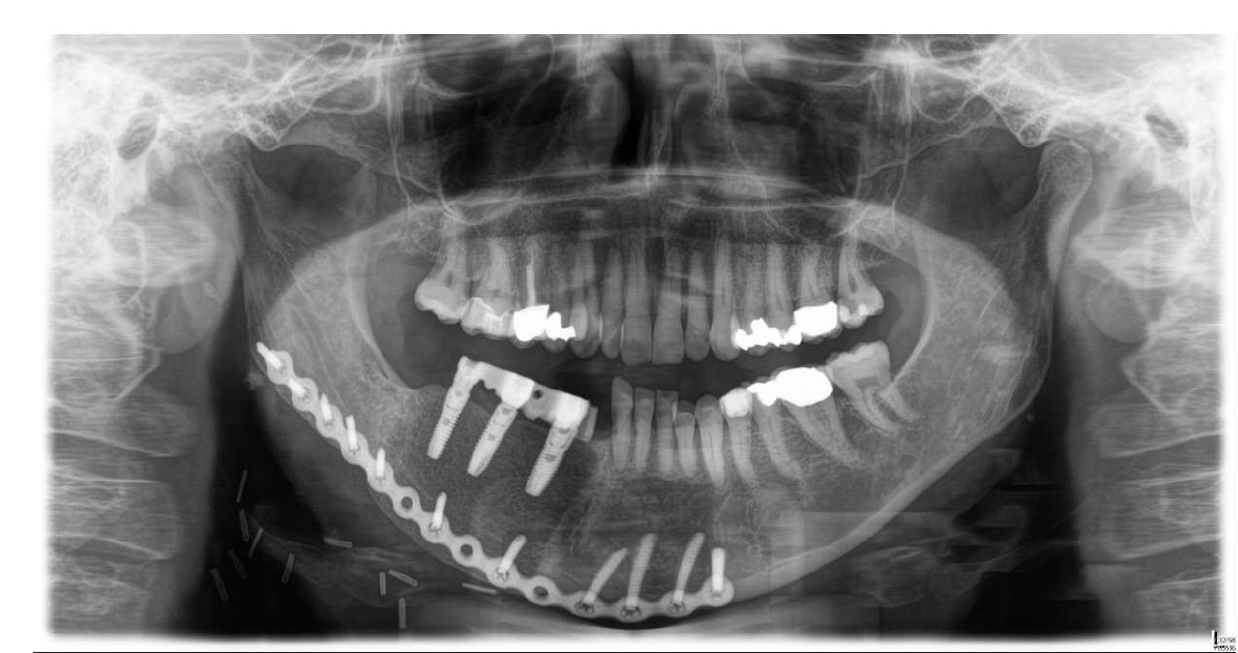
Figure 6. X-ray showing the postoperative situation, one year after surgery. Implant-prosthetic rehabilitation was success- fully performed in the affected area.